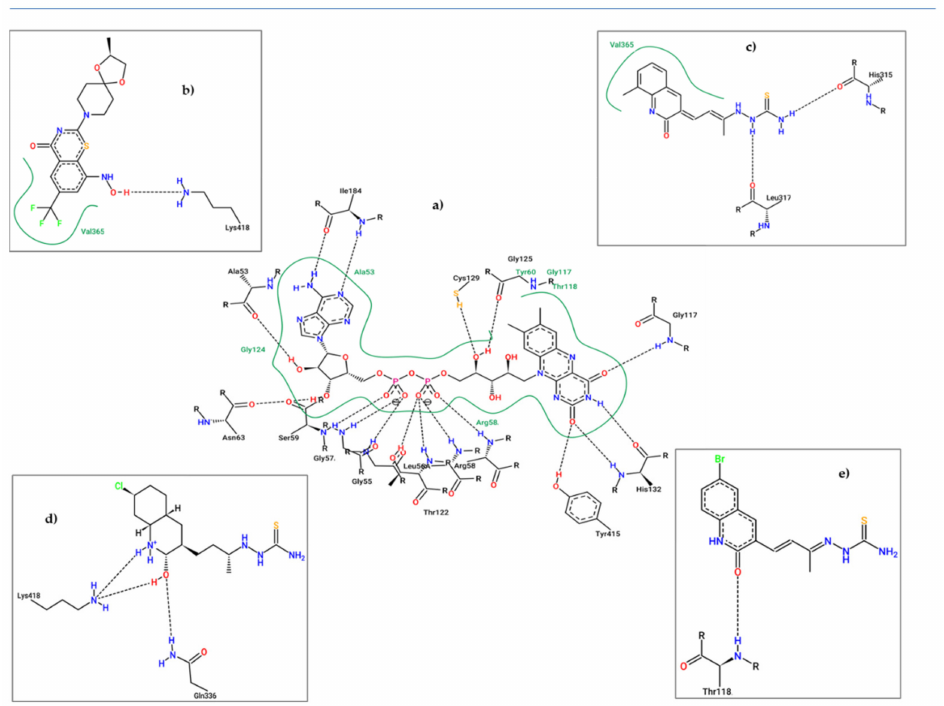
Figure 15. 2D Representation of the interaction between DprE1 and FAD ( a ), BTZ043 ( b ), 11c ( c ), 11d ( d ), and 11e ( e ).